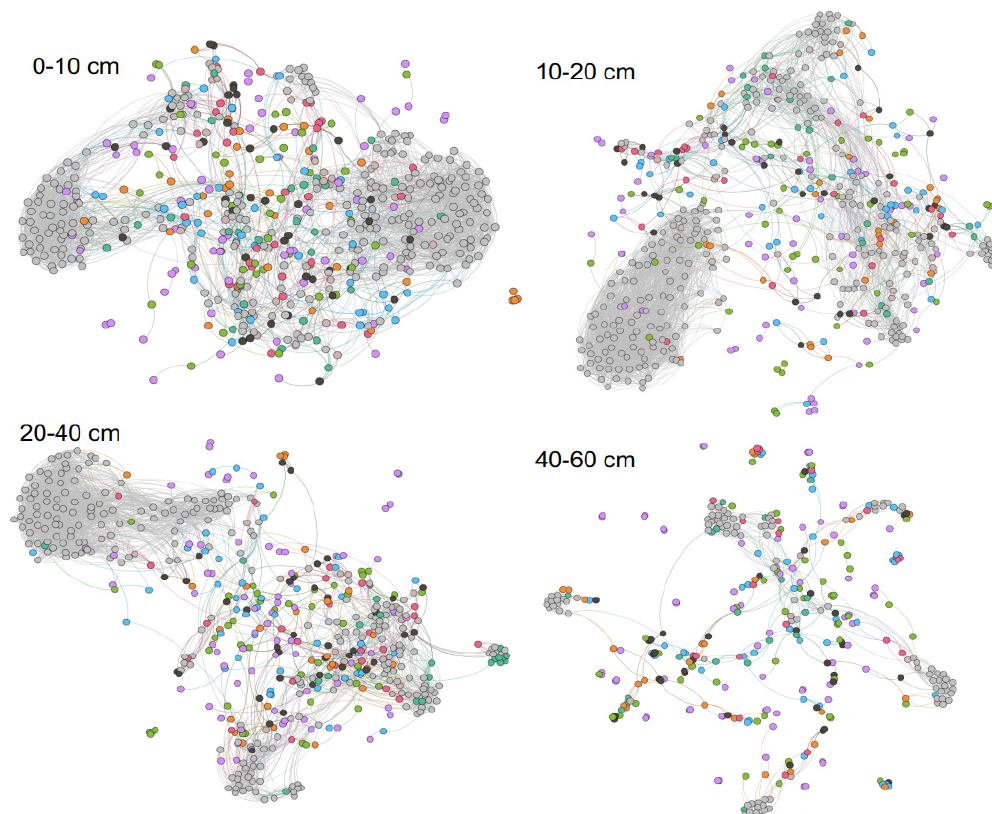
Figure 4. Co-occurrence networks of fungal communities at 14 studied sites with different fertility. Networks are randomly colored by